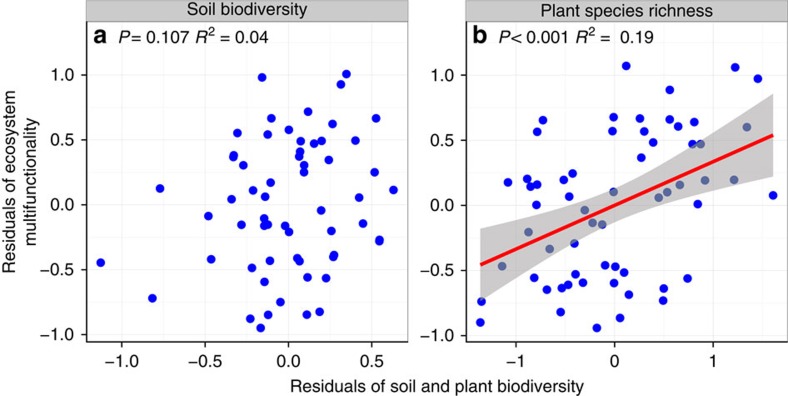
The relative effects of below- and aboveground biodiversity on ecosystem multifunctionality.The relative effects of soil biodiversity (a) and plant species richness (b) on ecosystem multifuncitonality (EMF).The red fitted line is from a partial linear regression. Only significant fitted lines are shown on the graphs. The results of variance partitioning for soil biodiversity and plant species richness are shown by the R2 on this graph. Shaded areas show 95% confidence interval of the fit.